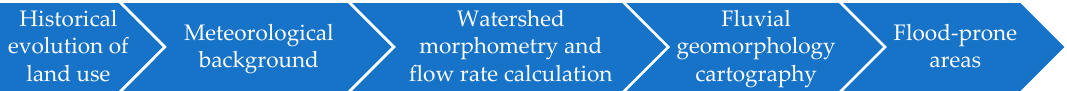
Figure 2. Flow chart with all the items that constitute the methodology.